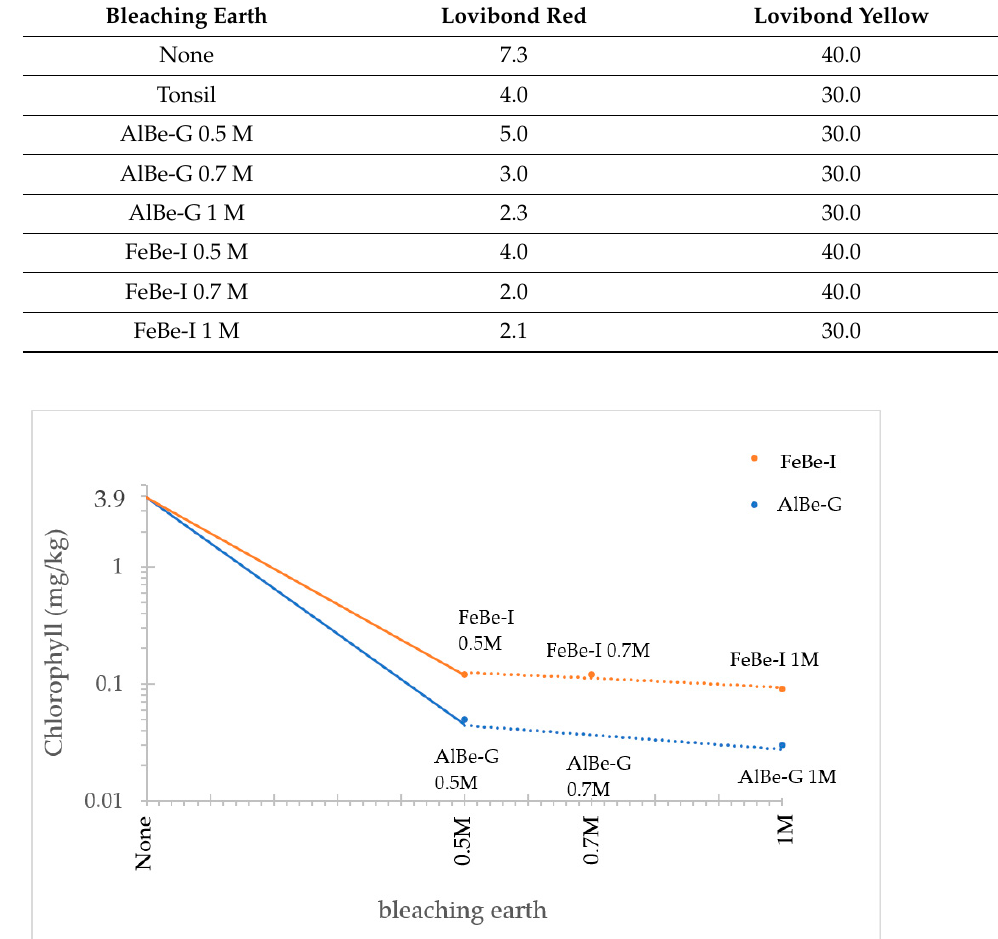
Figure 10. Chlorophyll values before and after bleaching tests with oxalic acid activated bentonites in soybean oil (80 °C, t = 30 min, 250 rpm, 3% w / w ). Lovibond red and yellow (which are associated with carotene content [39]) are also reduced after bleaching compared to untreated oil. It is observed that the oil treated with oxalic-acid-activated bentonites presents lower values of Lovibond red compared to that treated with Tonsil. Furthermore, the results show that as the concentration of oxalic acid during the activation of bentonites increases, the red colour decreases, and